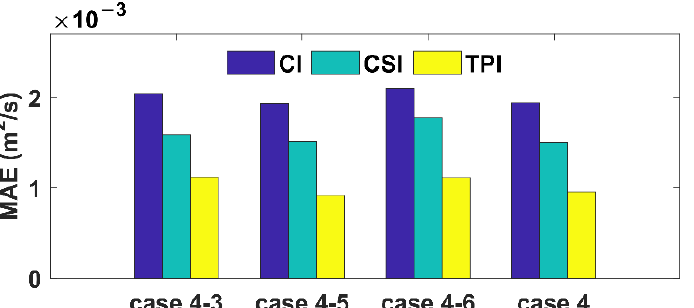
Figure 6. The MAEs between the given and inverted VEVCs with different BLDs in Cases 4-3, 4-5, 4-6, and 4. 4-6, and